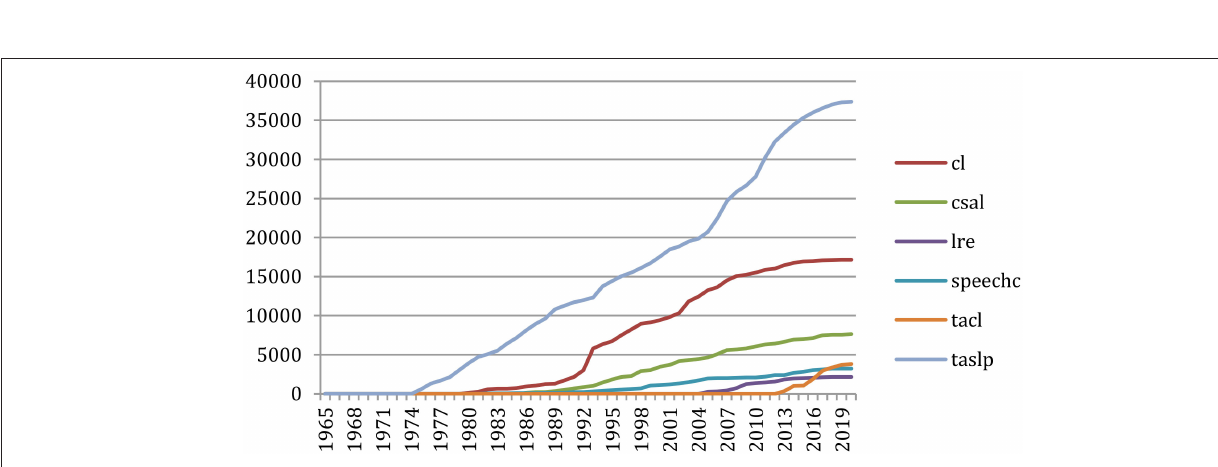
FIGURE 20 | Number of references to papers of 6 major journals over the